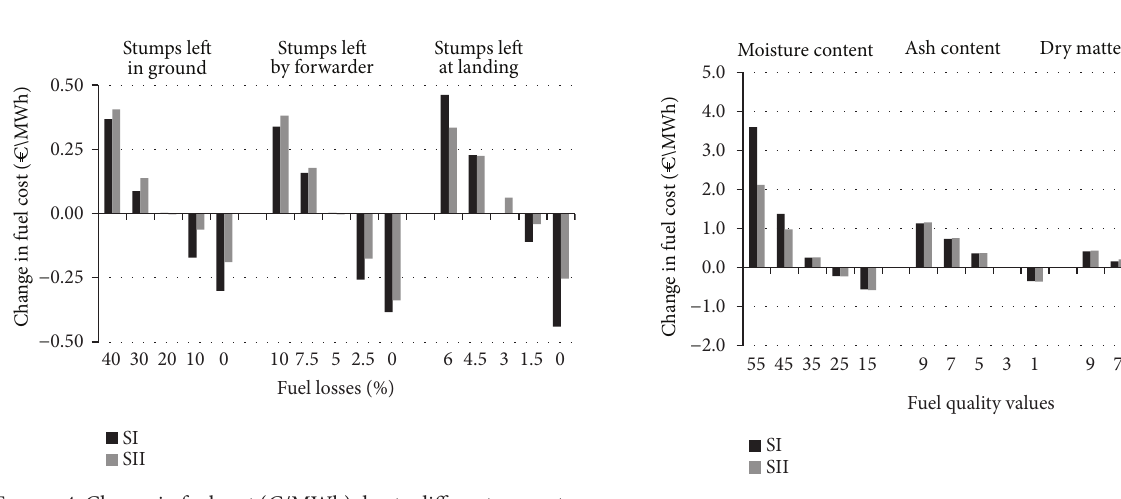
Figure 4: Change in fuel cost (C/MWh) due to different percentage Figure 5: Change in fuel cost (C/MWh) due to different storage of stumps being left at various locations in systems SI and SII. The outcomes regarding moisture content, wet basis (%), ash content, losses are in relation to ingoing material at each stage. dry basis (%), and dry matter losses (%) in systems SI and Table 5: Effect on fuel cost (C /MWh) of simultaneous changes in all factors related to machine productivity or operation time (SF7–11) from a low to a high case in systems (I) and (II). System 21.6 13.4 21.6 13.9